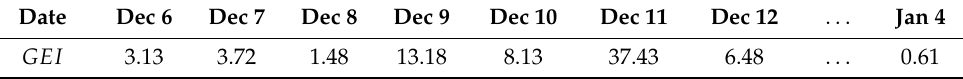
Table 2. Time series of GEI with geo-tagged check-ins identified as the ’Umbrella Movement’